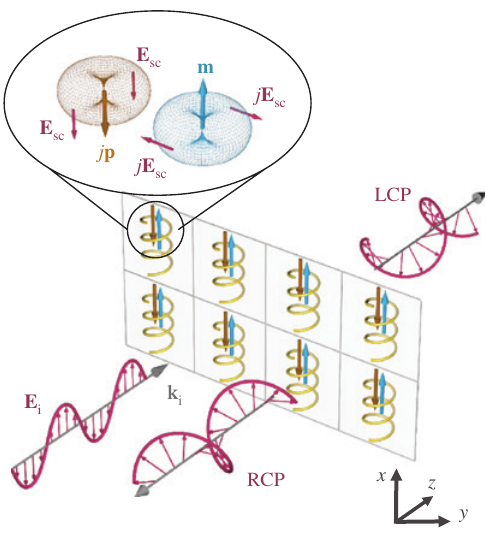
Figure 6: Electromagnetic response of a basic metasurface formed by chiral right-handed balanced inclusions. The inset depicts the radiation patterns of the electric and magnetic dipole